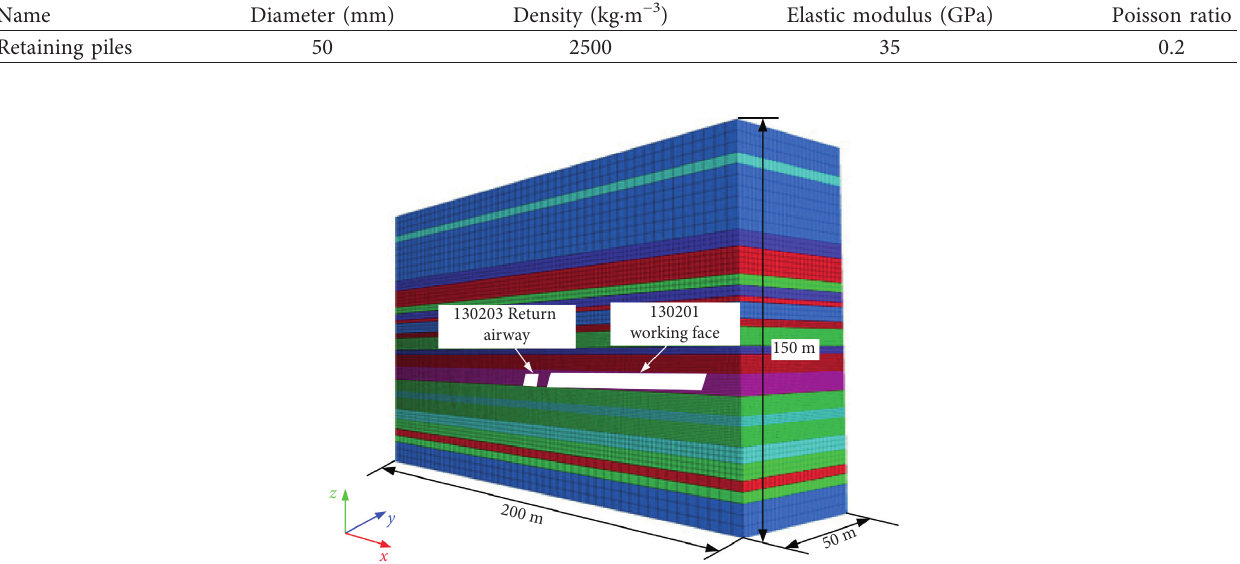
Table 2: Physical and mechanical parameters of retaining pile.